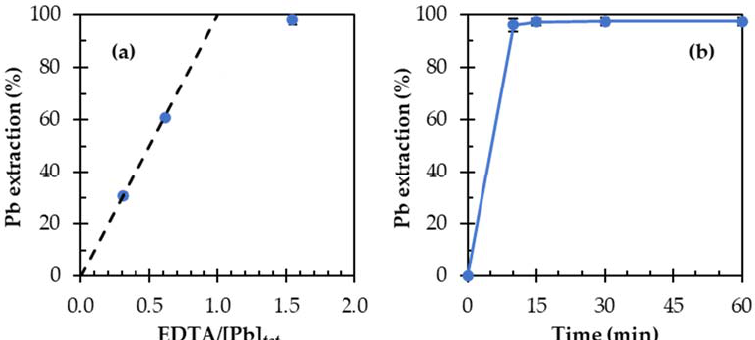
Figure 3. ( a ) Extraction efficiency of PbSO 4 after 24 h with different concentrations of EDTA (100, 200, or 500 mM) and ( b ) effect of time on PbSO 4 extraction with 500 mM EDTA. Note that the dotted line in Figure 3a corresponds to the ratio of EDTA/[Pb] tot .